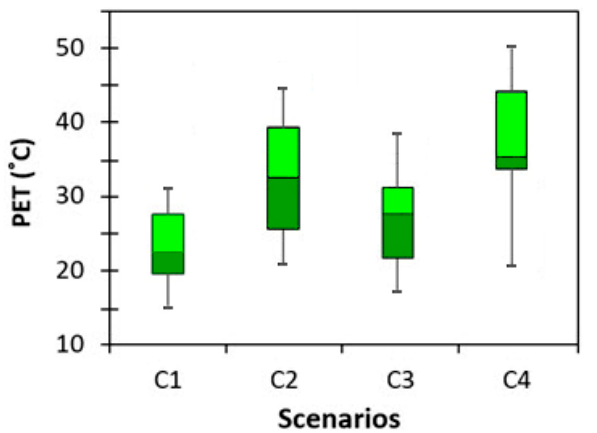
Figure 8. Average of PET values at the site (1.5 m agl) in all scenarios, during on the hottest day of the year.